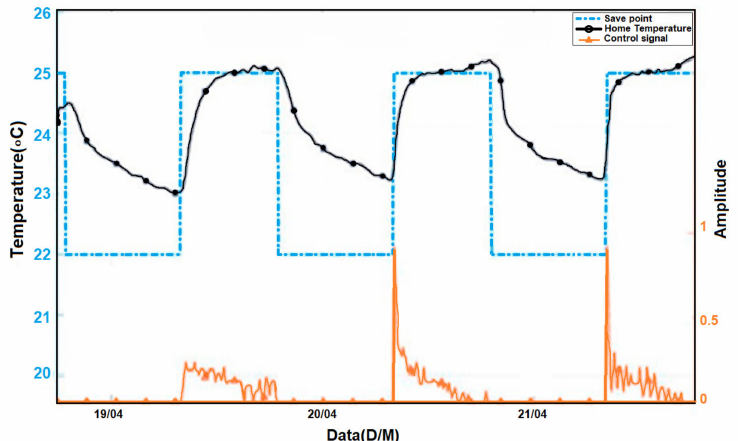
Figure 15. Room temperature change during controller